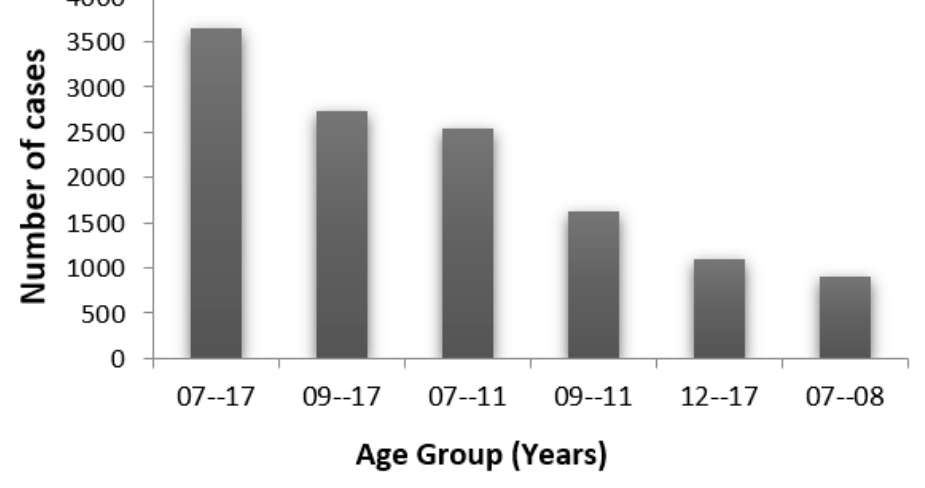
Figure 1. Case distribution for various age